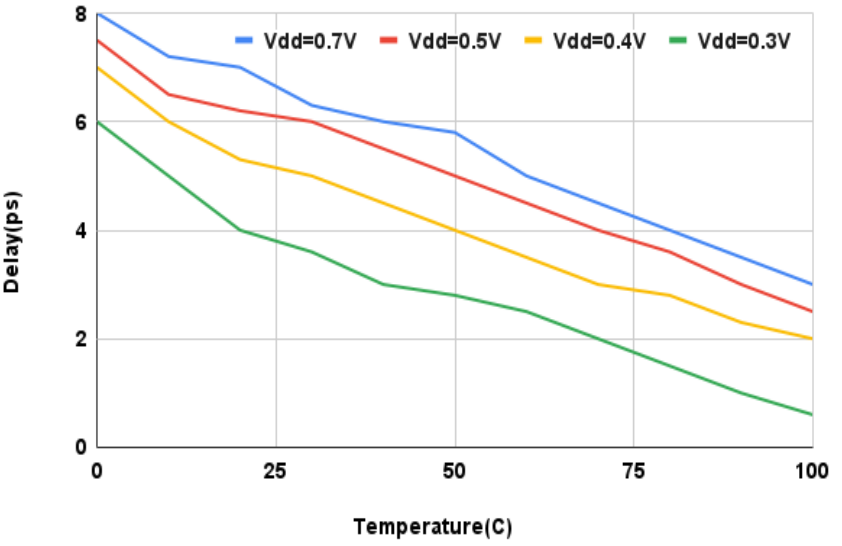
Figure 20. Simulation of delay with the variation of temperatures at different V dd of FinFET-based SRLC circuit at 7 nm.